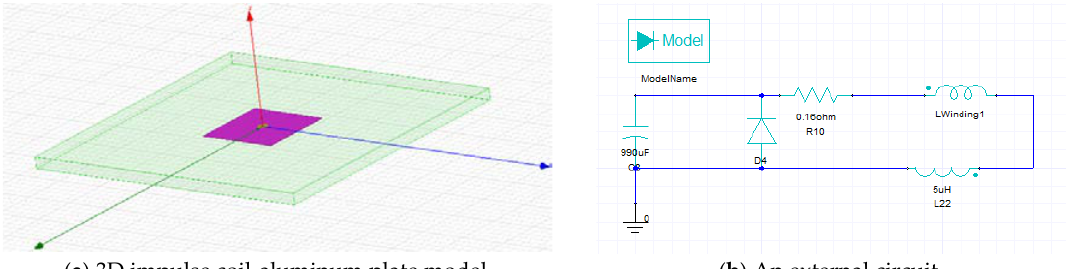
Figure 8. Electro-dynamic simulation model.